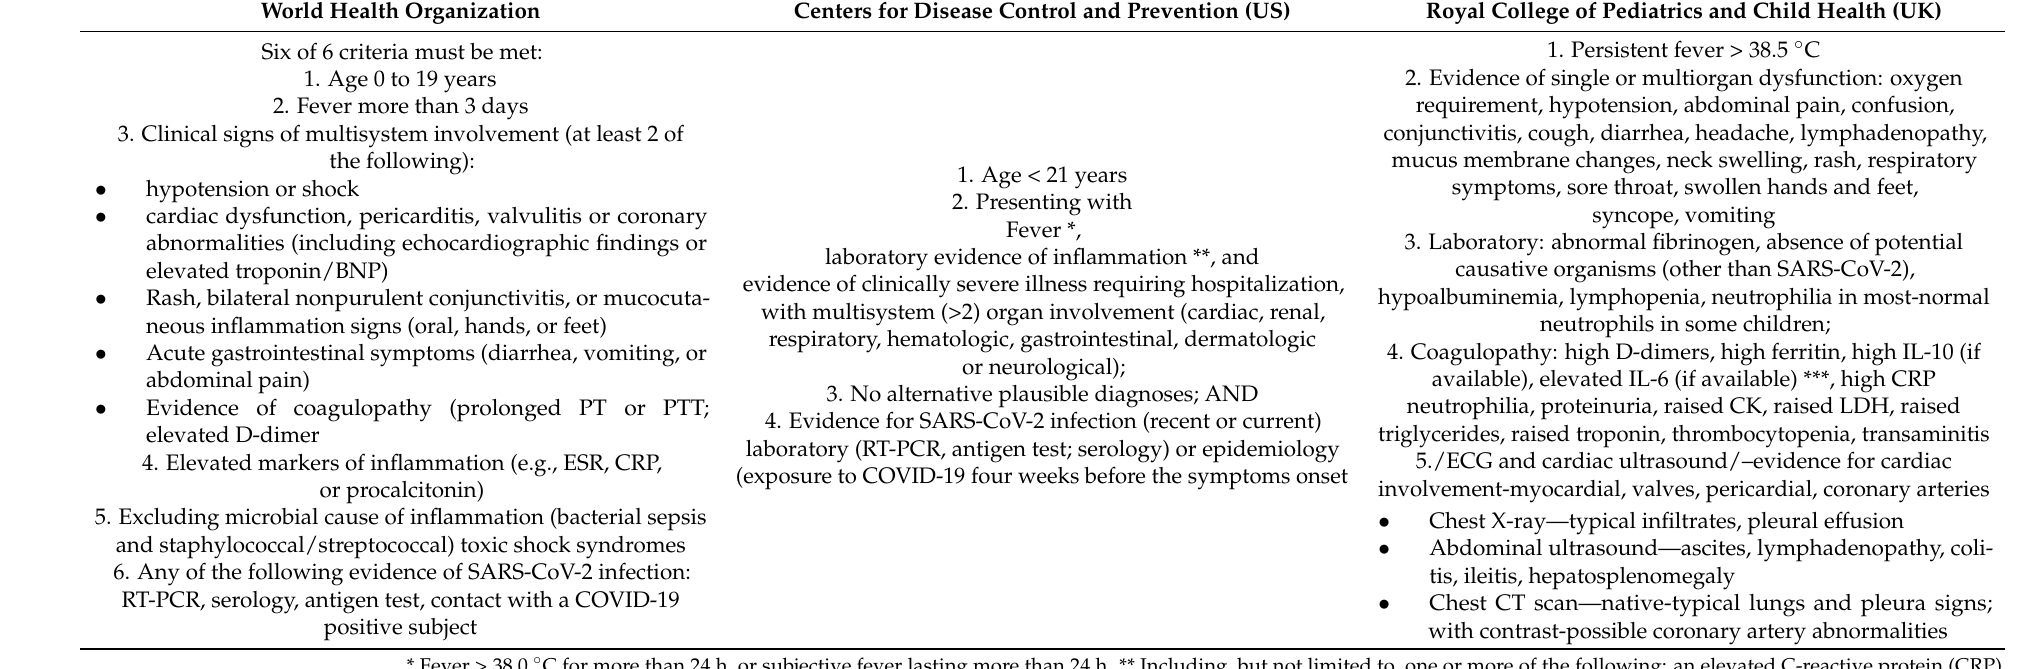
Table 1. Criteria for MIS-C diagnosis according to World Health Organization (WHO) [5], Centers for Disease Control and Prevention (CDC) [6] and Royal college of pediatrics and child health (RCPCH, UK) [7]